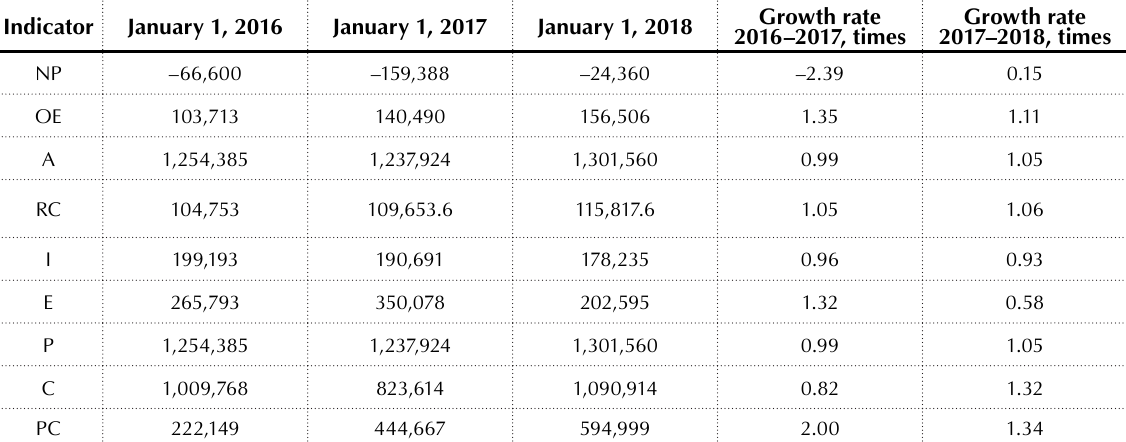
Table 6. Input statistic data of the Ukrainian banking system, 2016–2018, in UAH